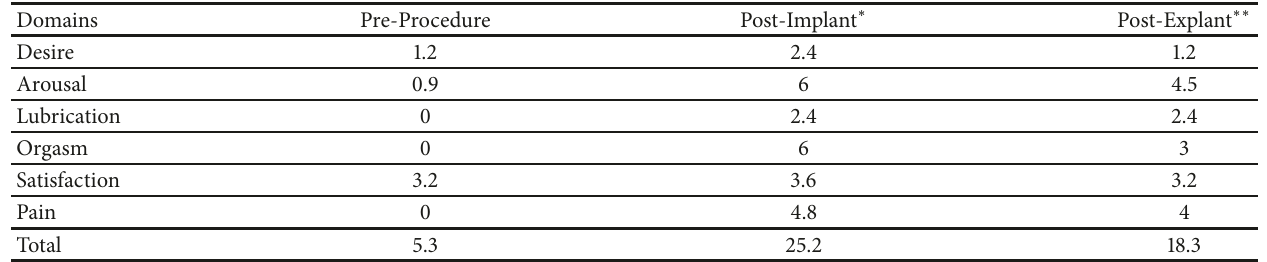
Table 1: FSFI scores prior to implant, 6 months following the implant, and 12 months following the